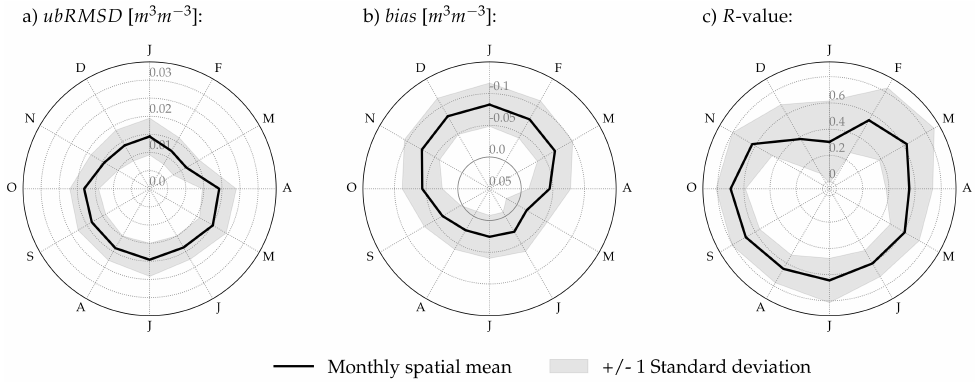
Figure 6. Polar plots of the monthly ( a ) ubRMSD , ( b ) bias & ( c ) R between the mean daily API and ESA CCI